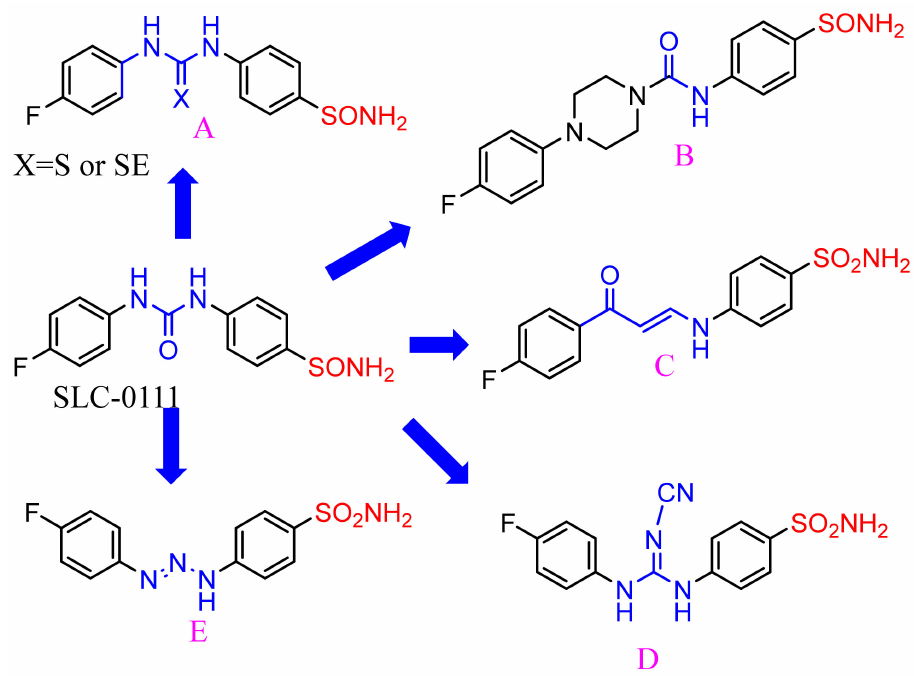
Figure 1. The main structural feature and similarity of reported h CA IX and XII inhibitors( A – E ) with SLC-0111 (patent compound).